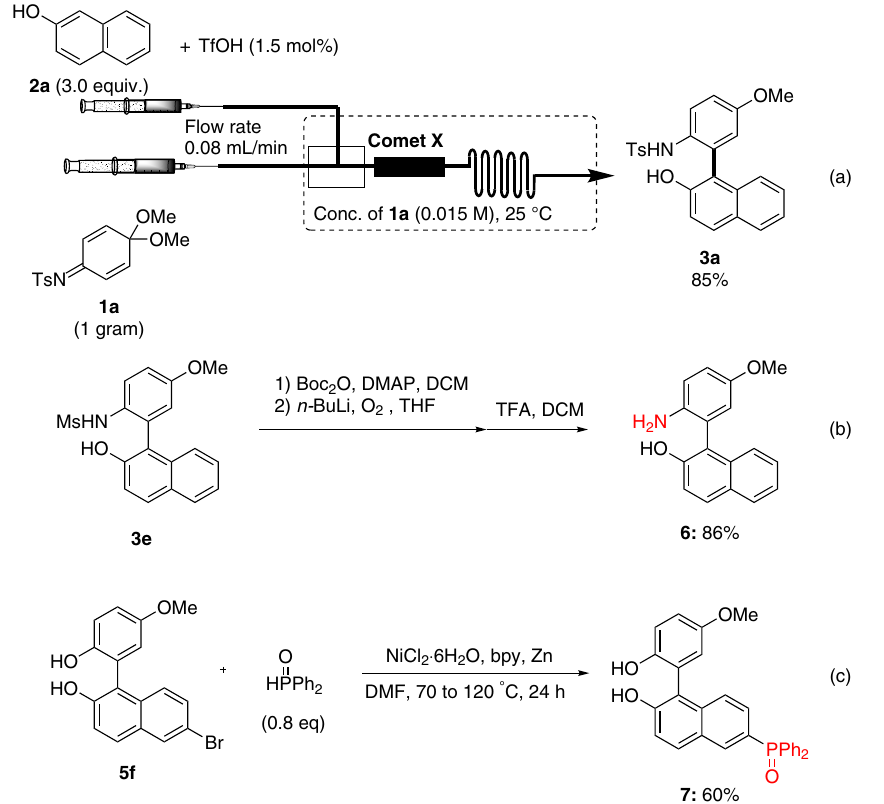
Fig. 4 Gram-scale synthesis of 3a and synthetic applications of 3e and 5f. a Gram-scale synthesis of 3a under the optimized conditions. b Removal of Ms group. c Reductive coupling of 5f with diphenyl phosphine oxide.